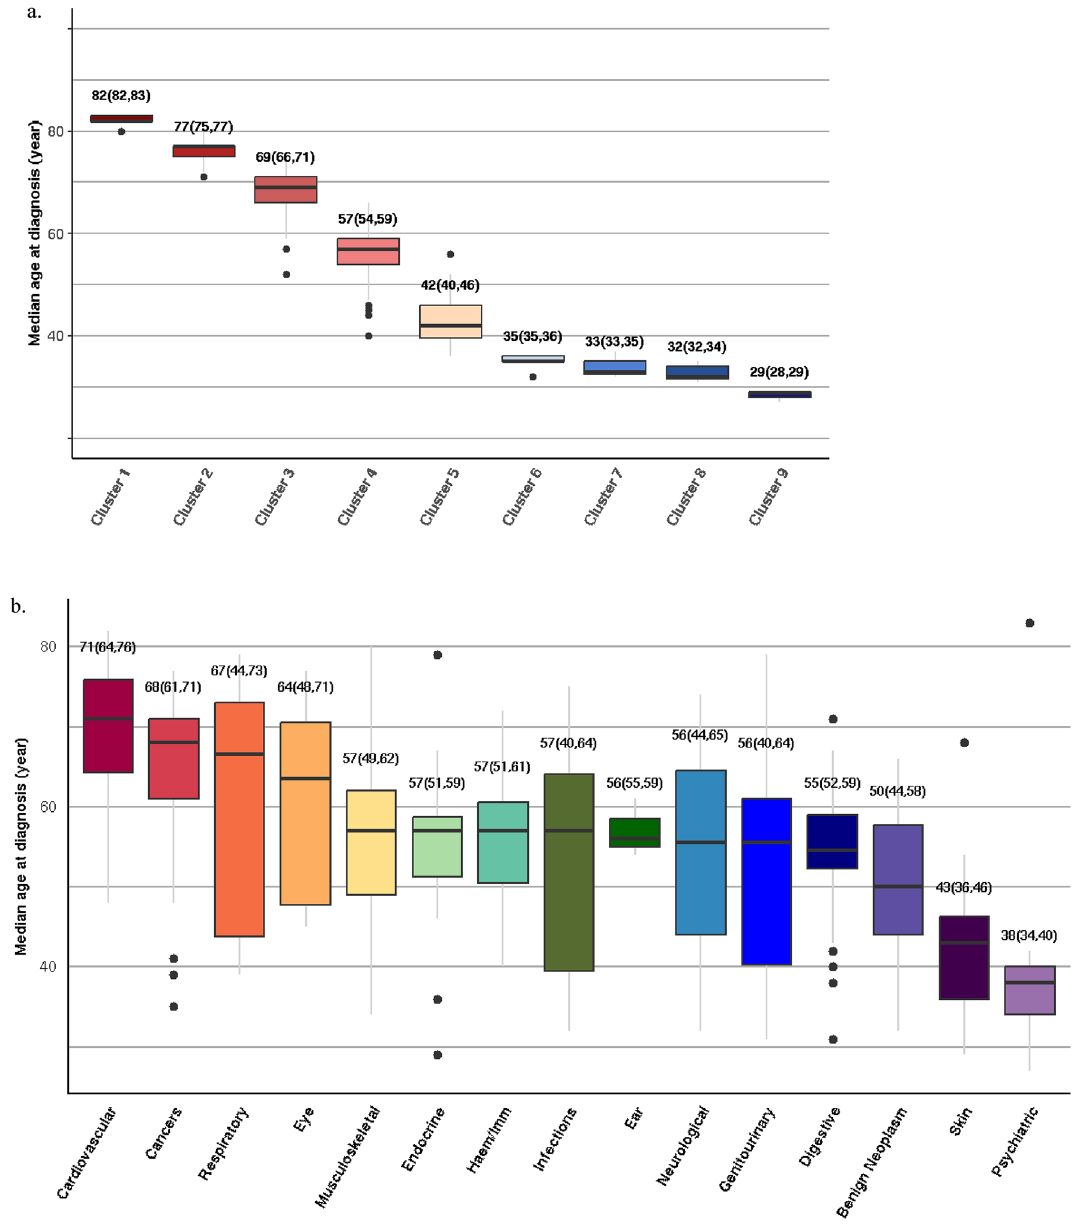
Figure 4. Median age of onset for 278 diseases in each curve cluster and disease category: ( a ) Box and whisker plots of the median age of first recorded diagnosis above the age of 20 years for diseases in each curve cluster; ( b ) Box and whisker plots of the median age of first recorded diagnosis (above the age of 20 years) for the 289 conditions grouped into 15 disease categories. The horizontal line inside the boxes represents the median, the upper and lower edges of the boxes represent the 25th and 75th percentiles, and the end-points of the upper and lower whiskers represent the highest and lowest values within 1.5*IQR, where IQR is the interquartile range. Numbers above the boxes indicate the median (25th percentile, 75th